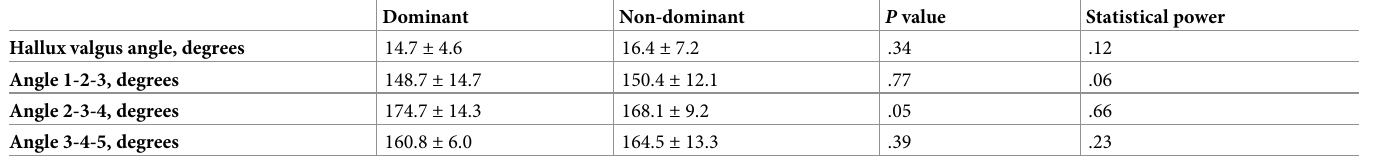
Table 3. Comparison of the alignment of metatarsal bone heads between both